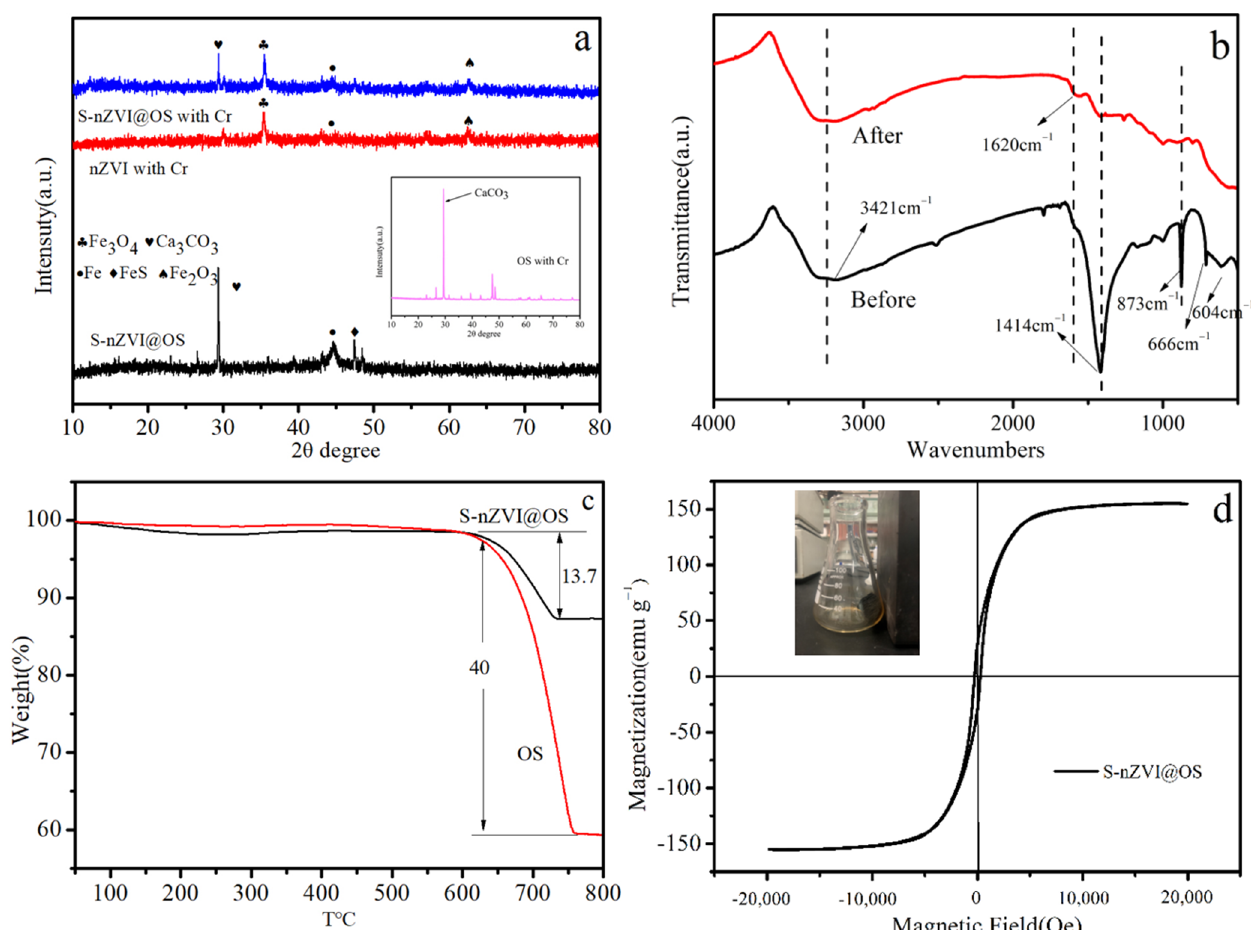
Figure 4. ( a ) XRD patterns of different composite before and after removal Cr (VI) (inset figure is the XRD pattern of OS after reaction with Cr (VI)); ( b ) FTIR spectra of S-nZVI@OS before and after reaction; ( c ) TG thermogram of OS and S-nZVI@OS; ( d ) magnetization curve of S-nZVI@OS.